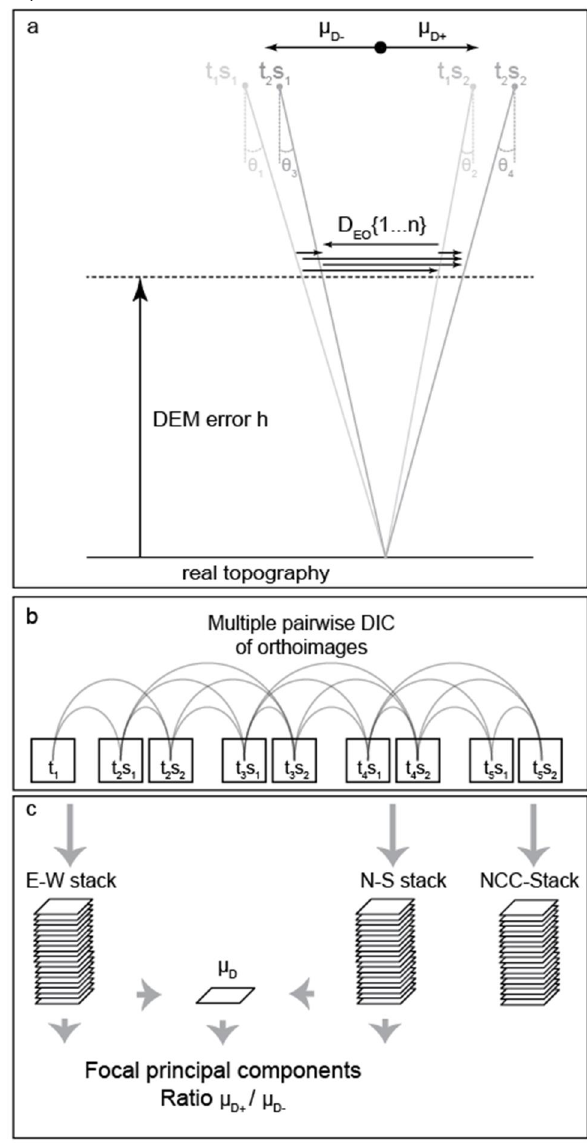
Figure 1. Overview of the proposed processing chain.